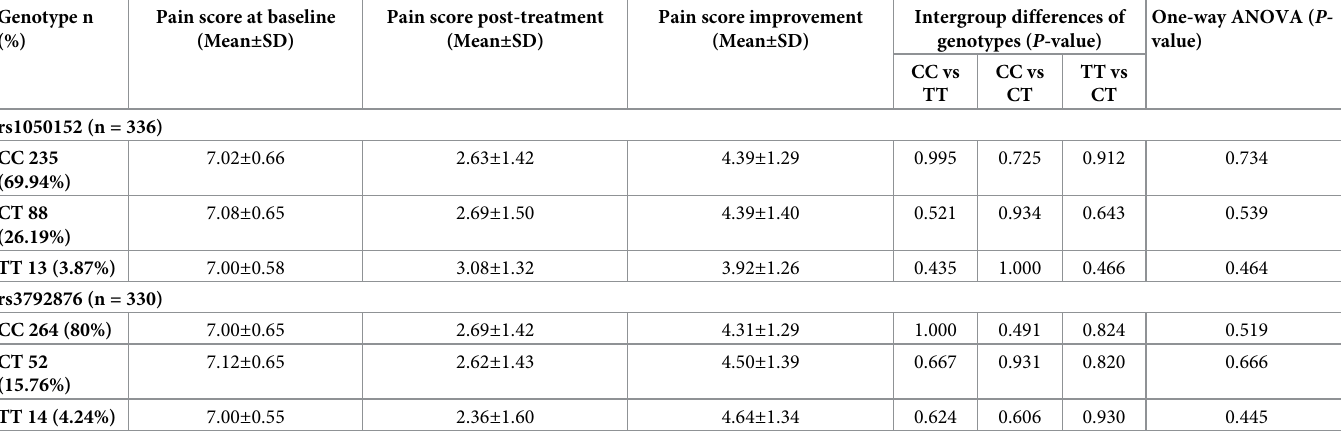
Table 3. Effect of OCTN1 rs1050152 and rs3792876 polymorphisms on pain score difference in responders (complete and partial) after gabapentinoids treatment. Genotype n (%)